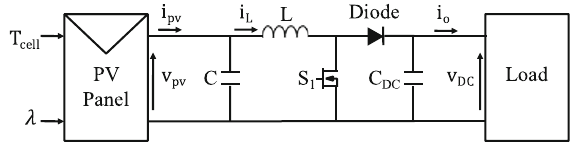
Fig. 3 The schematic of the DC-DC boost